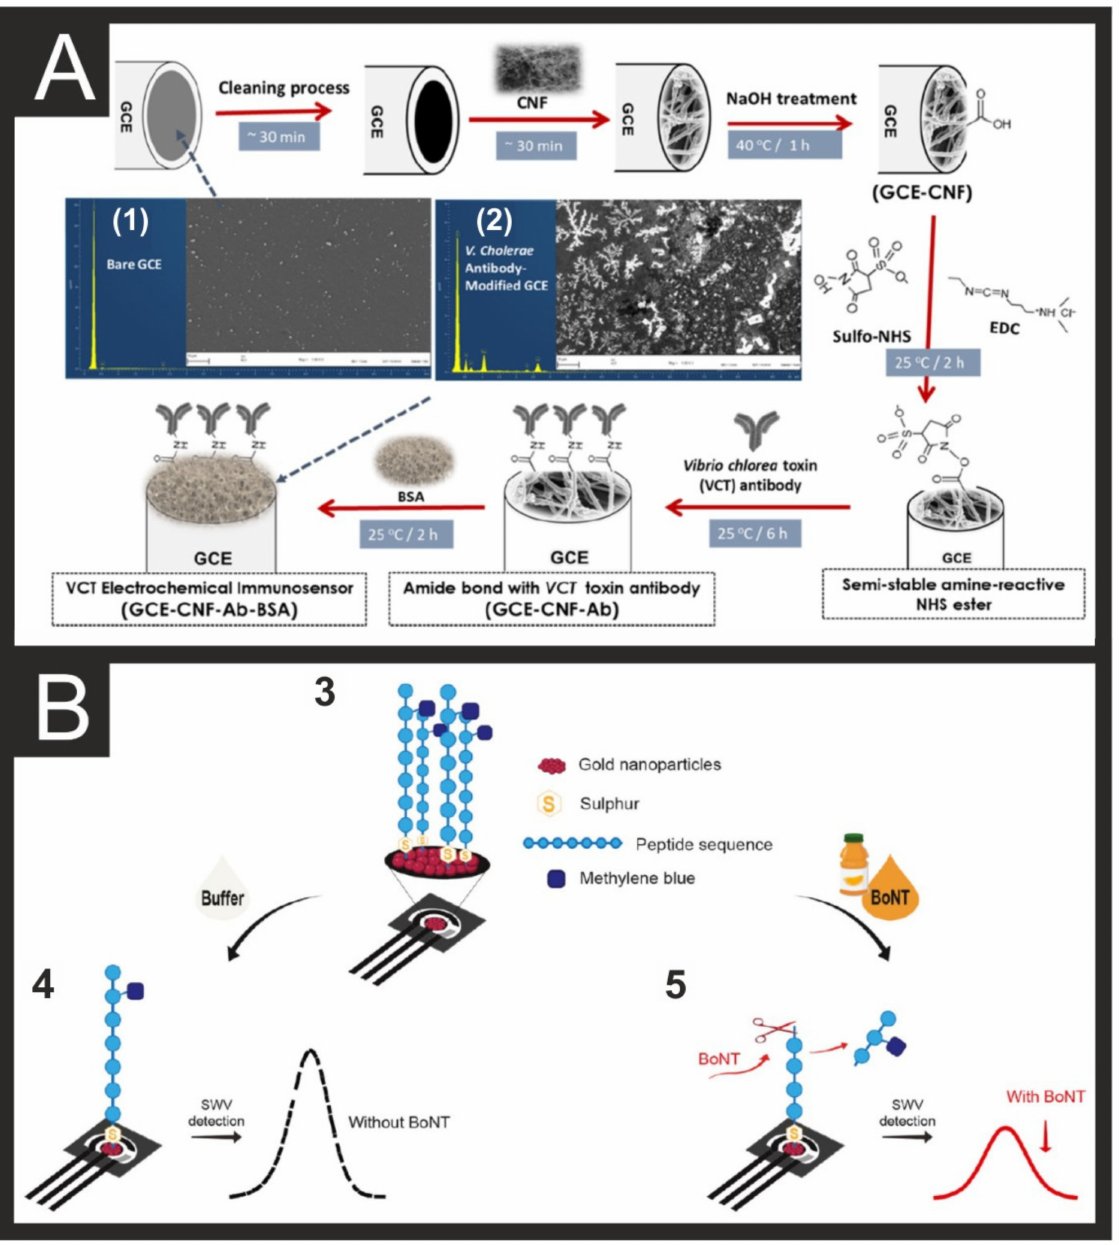
Figure 3. ( A ) Experimental protocol (and time needed) for the fabrication and sensing mechanism of an electrochemical immunosensor for VCT. Inset (1) shows typical SEM and EDX of a bare GCE, while (2) shows SEM and EDX of V. cholerae antibody-modified GCE. Reproduced with permission from [43]. Copyright American Chemical Society 2020. ( B ) Experimental protocol for the BoNT detection using the signal-off method, including a representation of the peptide- modified paper-based sensor (3), signal obtained before analyte presence (4), and signal obtained after analyte presence (5). Reproduced with permission from [45]. Copyright Elsevier 2021. Algae/Algal